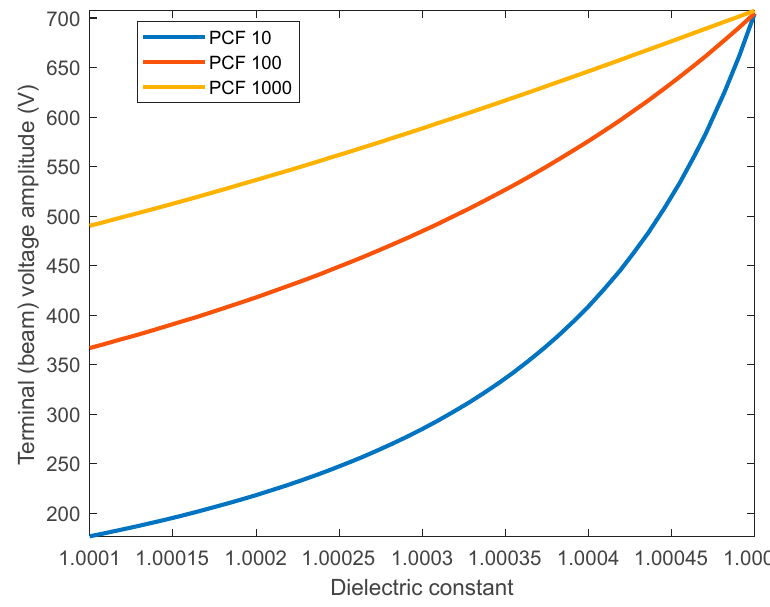
Figure 12. The e ff ect of parasitic capacitance on the voltage amplitude dependence on dielectric constant.